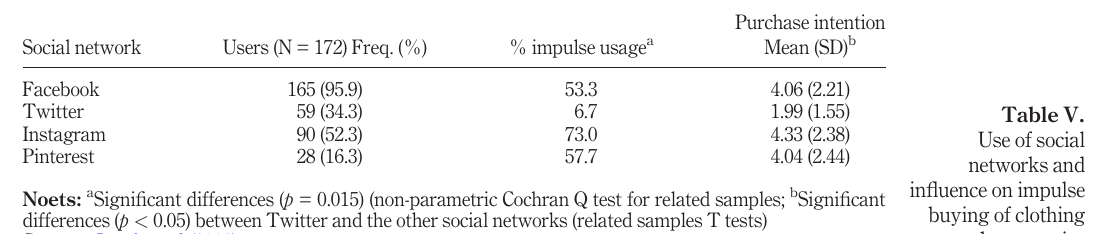
Multiple regressions of the encouraging and discouraging factors of online impulse buying